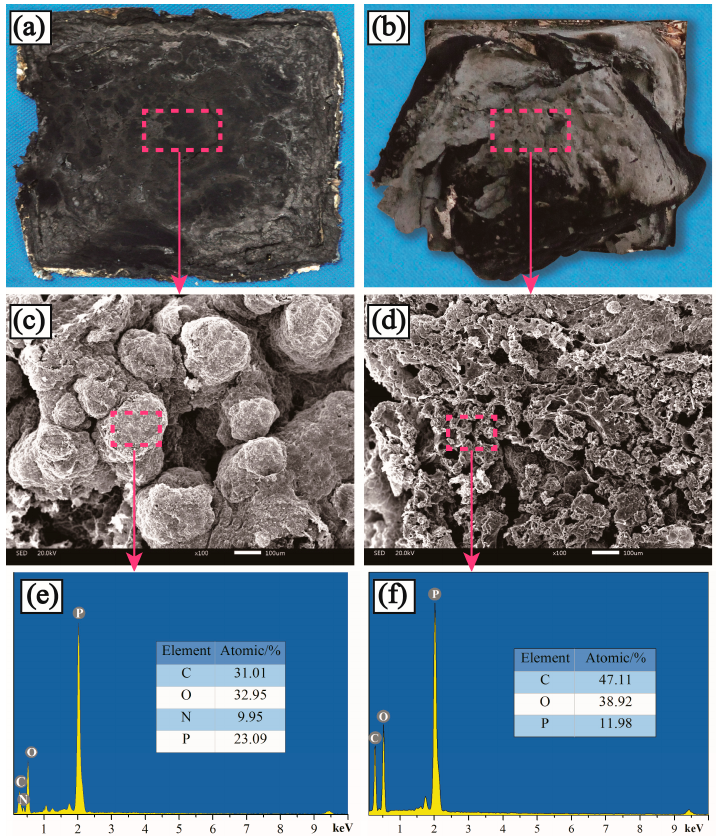
Figure 10. Photos, SEM (scanning electron microscopy) images and chemical compositions of residue char for PP4 and PP7.